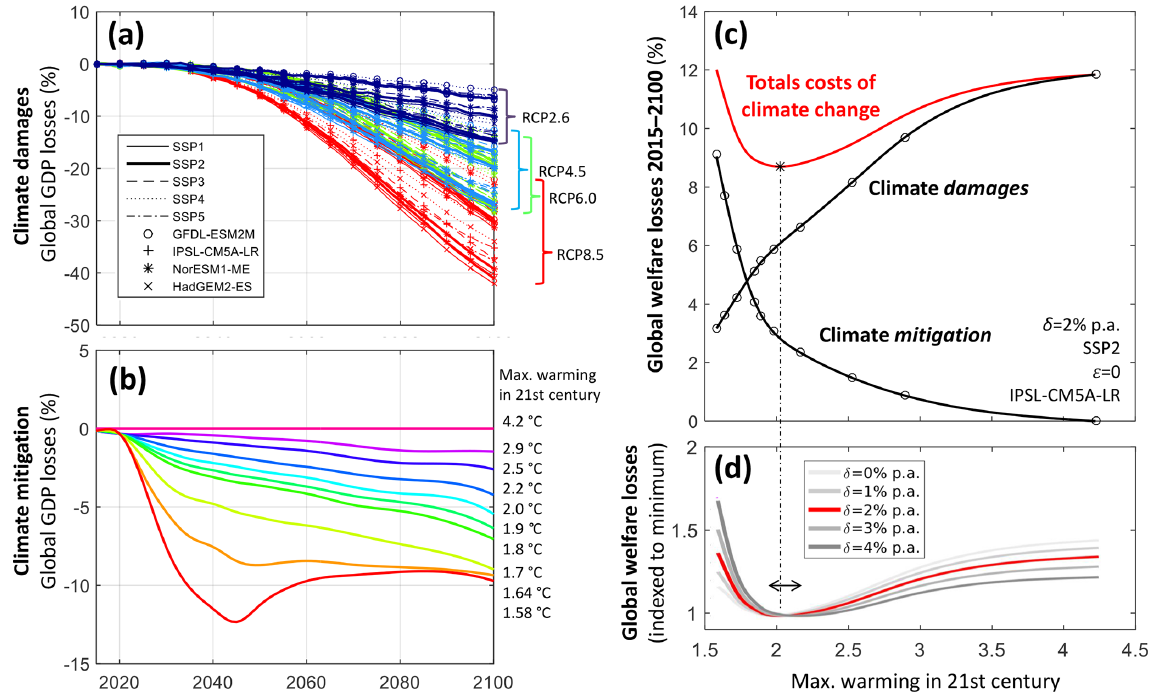
Figure 1. Deriving the economically optimal global warming limit. (a) Global annual GDP losses from climate-change impacts derived from the observed non-linear relationship between country-specific temperature fluctuations and GDP growth shown for four general circulation models (GCMs), five Shared Socioeconomic Pathways (SSPs), and four Representative Concentration Pathways (RCPs). Negative values correspond to losses. (b) Global annual GDP losses from climate-change mitigation as estimated with the REMIND model (Luderer et al., 2013; Rogelj et al., 2015) for global warming limits (colour coding) from 1.6 to 4.2 ◦ C above preindustrial levels. Negative values correspond to losses. (c) Cumulated global welfare losses (2015–2100) from climate damages, climate mitigation, and their combined effect (total costs), as a function of global warming limits illustrated from an example scenario (SSP2, GCM: IPSL-CM5A-LR, inequality aversion ε = 0, pure rate of time preference δ = 2%yr − 1 ). Total costs are derived in three steps: (i) climate impacts and climate mitigation are combined by reducing the reference GDP (without climate change) successively by the two relative annual country-specific GDP losses; (ii) resulting country-specific GDP pathways (with and without climate change) are translated to per capita utility via an isoelastic utility function with varying inequality aversion; (iii) resulting utilities are globally and temporally (2015–2100) aggregated to a social welfare function varying the pure rate of time preference. (d) Dependence of total cumulated welfare losses on pure rates of time preference. Losses are normalized by the minimum loss of each curve. The red line for δ = 2% corresponds to the red line in panel (c) (dashed vertical line). Cost-minimizing global warming limits slightly shift towards higher values with increasing pure rate of time preference (range indicated by